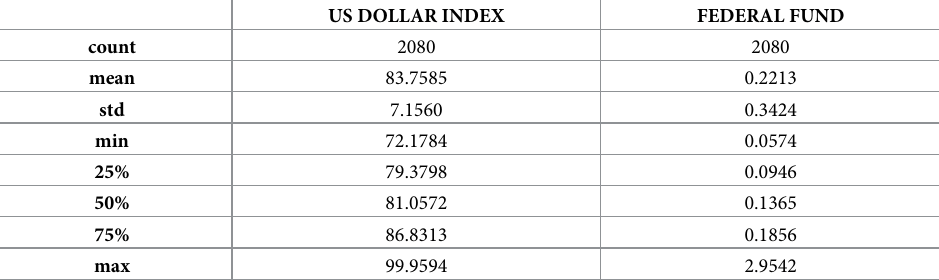
Table 3. Summary statistics of selected input variables (macroeconomic indicators) (S&P500).